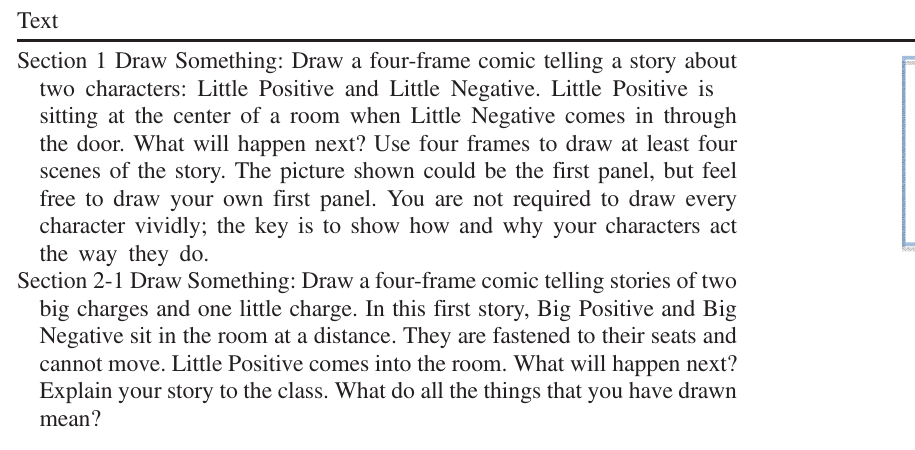
TABLE II. Comic Strip Activity tasks. Text First